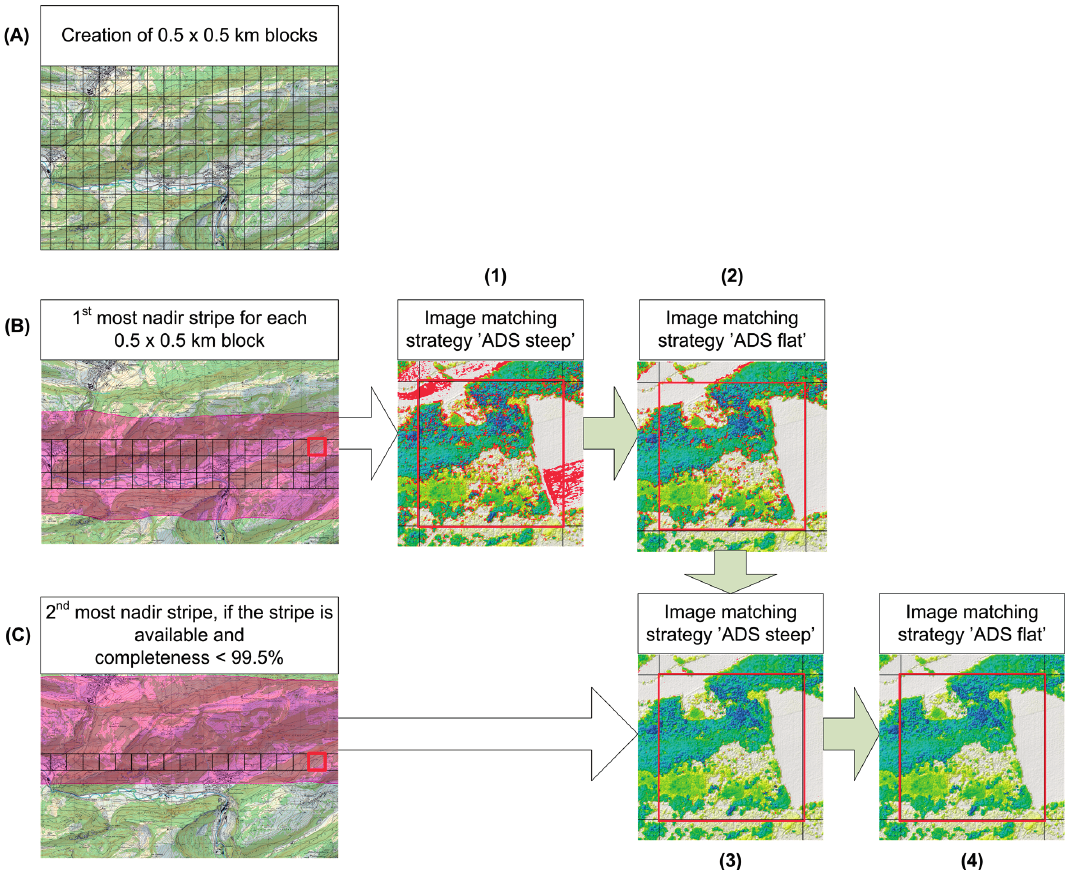
Figure 2. Image matching workflow. ( A ) Rasterizing into 0.5 × 0.5 km blocks; ( B ) selecting the stripe with the smallest distance from nadir to the centre of the block; and ( C ) selecting the stripe with the second smallest distance from nadir to the center of the block (1) The result after the matching process for the block using the 1st most nadir stereo stripe and the “ADS steep” image matching strategy. Red areas in the image could not be matched. The completeness for this block is 84%. (2) The result after applying the “ADS flat” matching strategy. At 91%, the completeness threshold is still not fulfilled. (3) The result after matching using the 2nd most nadir stripe and the “ADS steep” strategy (completeness 96%) and (4) the final DSM after “ADS flat” strategy with a matching completeness of 96%.